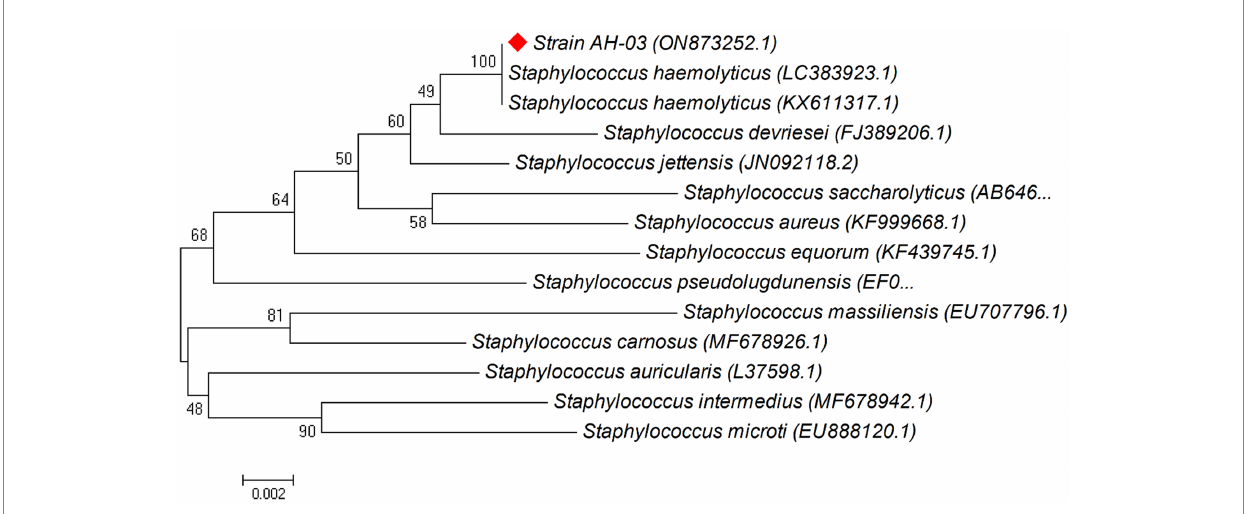
FIGURE 2 Phylogenetic relationship between the strain AH-03 and other 16S rRNA gene sequences of published strains. In the phylogenetic tree, AH-03 and Staphylococcus haemolyticus were clustered together as one clade. The scale bar corresponds to a 0.002 nucleotide substitution per sequence position. The number in parentheses represents the accession number in GenBank.